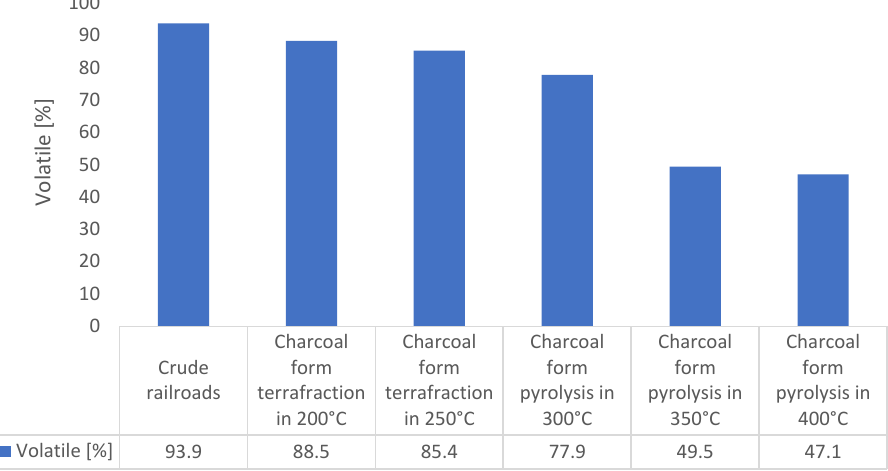
Figure 11. Volatile content of raw material (20 ◦ C) and the chars obtained with different final temperatures.